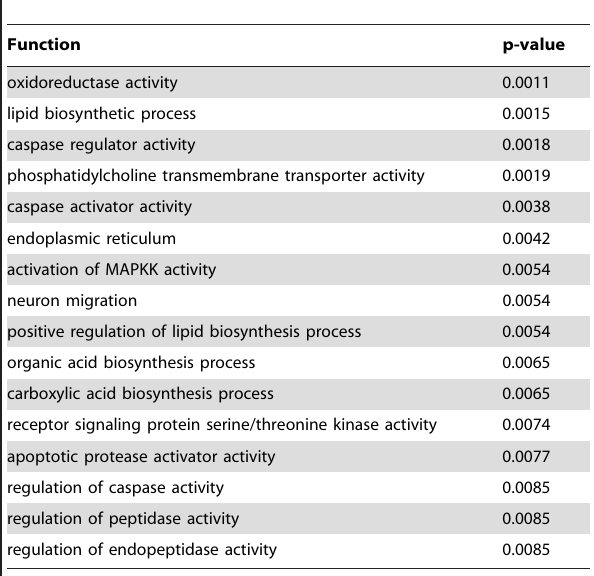
Table 3. Upregulated functions in CC MII compared to CC GV . Table 4. Downregulated functions in CC MII compared to